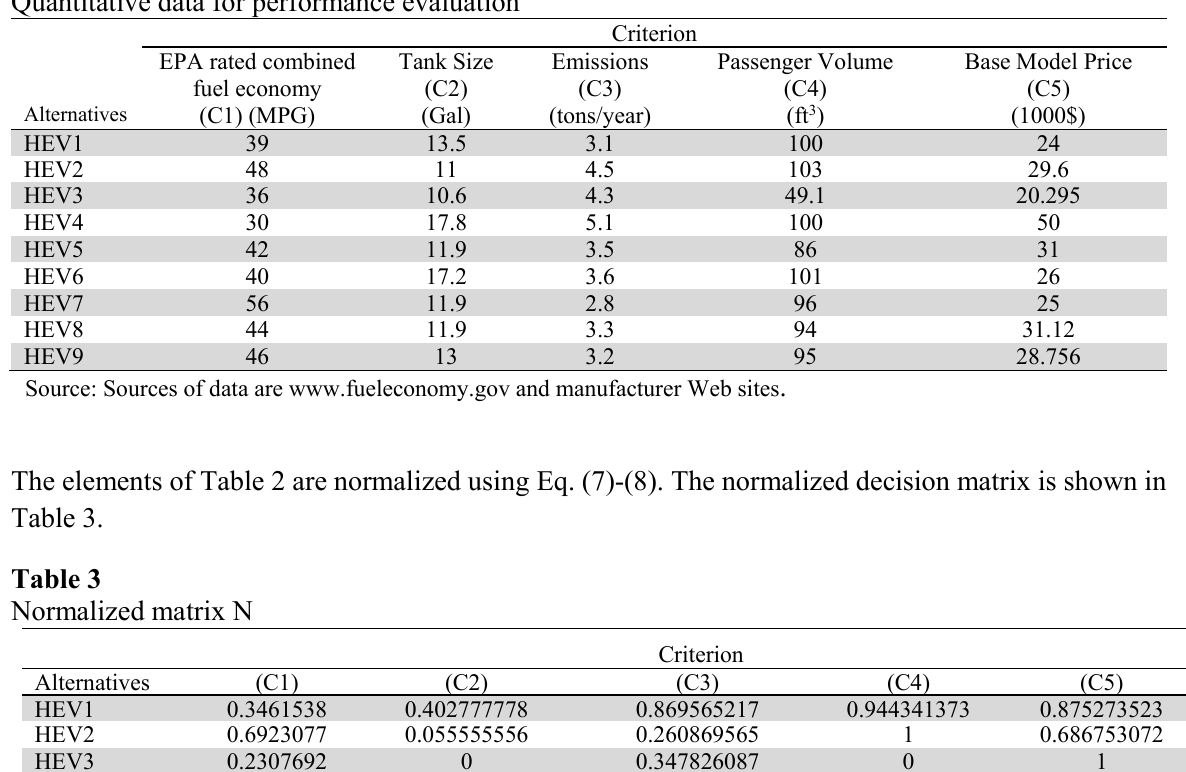
Quantitative data for performance evaluation